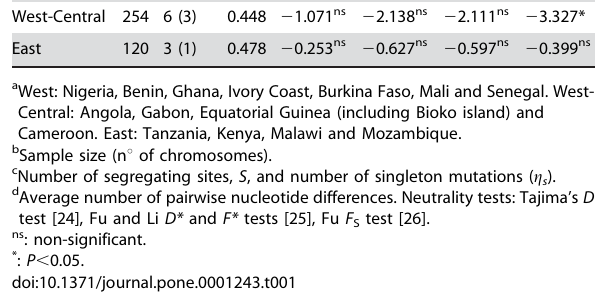
Table 1. Neutrality tests according to geographic region. ... ... ... .... ... ... .... ... ... .... ... ... .... ... ... .... ... ... .... ... ... .